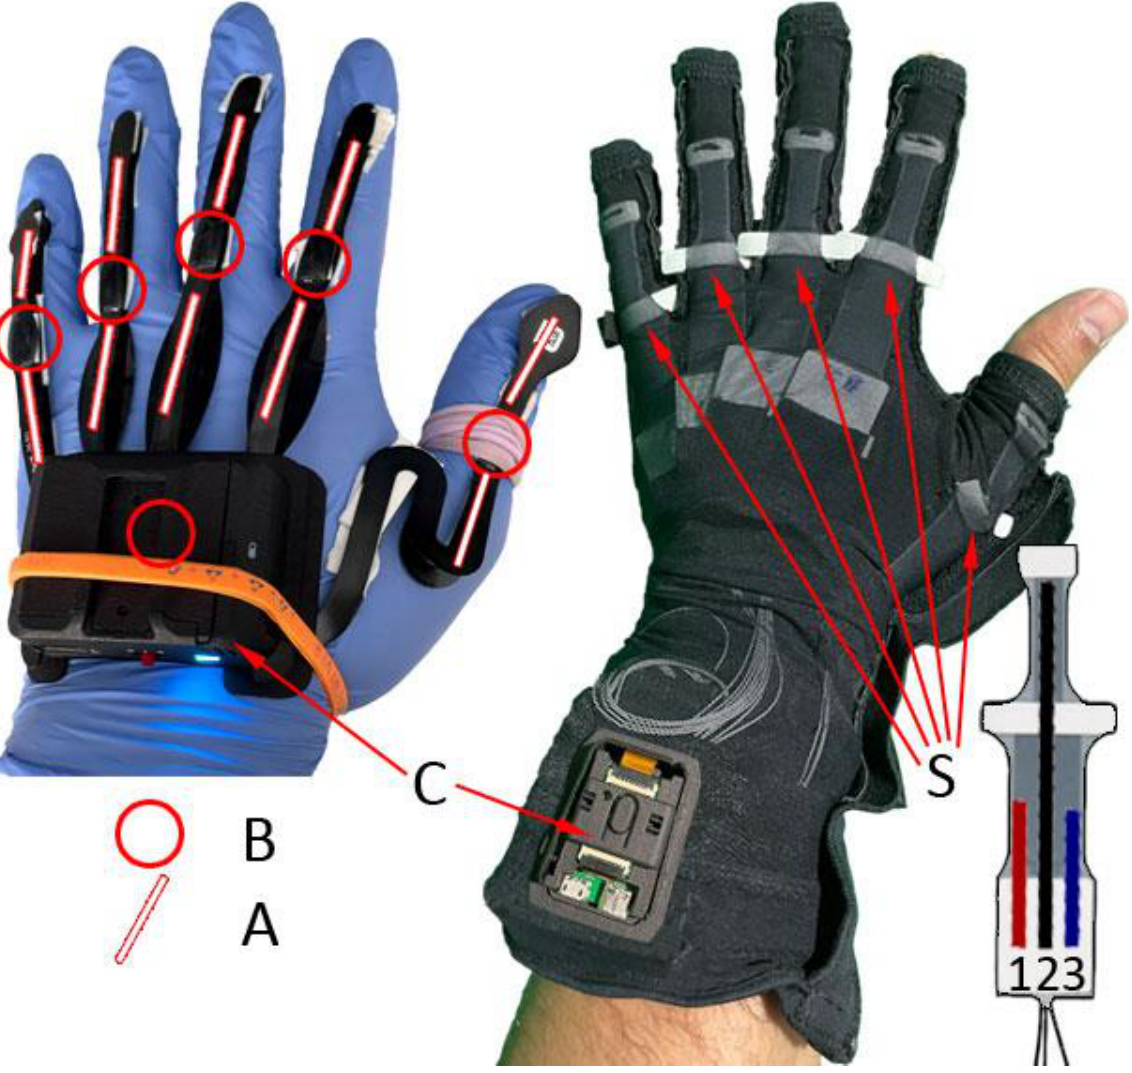
Figure 2. Distribution of the sensors in the Manus Prime II VR gloves (left) and the MoCap Pro Gloves (right). A—IMU; B—Rigid sensors; C—Bluetooth communication controller; S—Stretch sensors that measure the bend and splay of each finger.